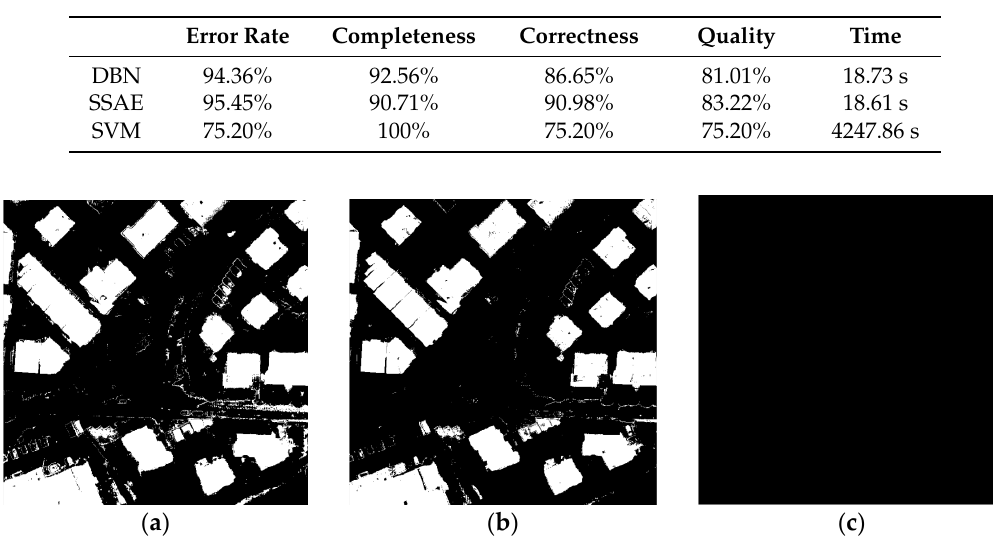
Figure 10. The result of Area30: ( a ) The result of DBN; ( b ) The result of SSAE; ( c ) The result of SVM. Table 5. Different methods of extraction results Area 30.